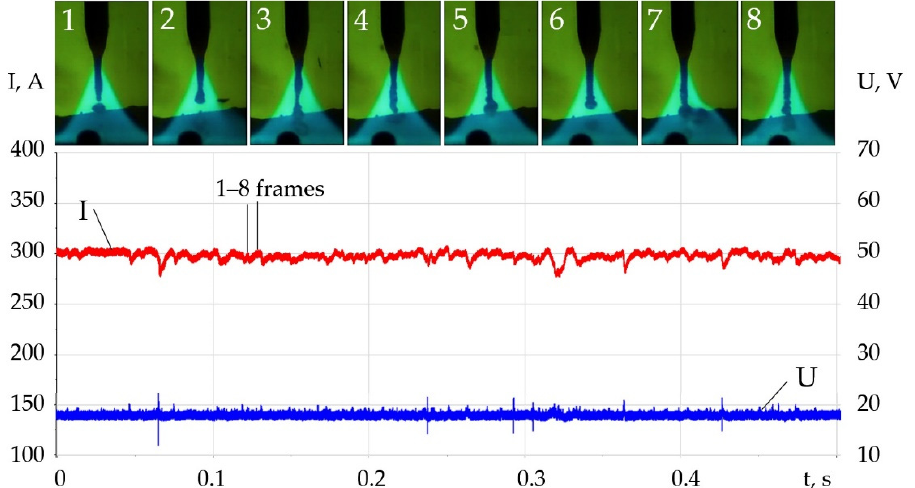
Figure 11. Change in the current and metal spray transfer during melting of a G3Si1 wire of 1.2 mm in argon with a Ni-LaF 3 coating of 15 μ m; time between the frames is 0.5 ms; 1–8 is a sequence of frames.